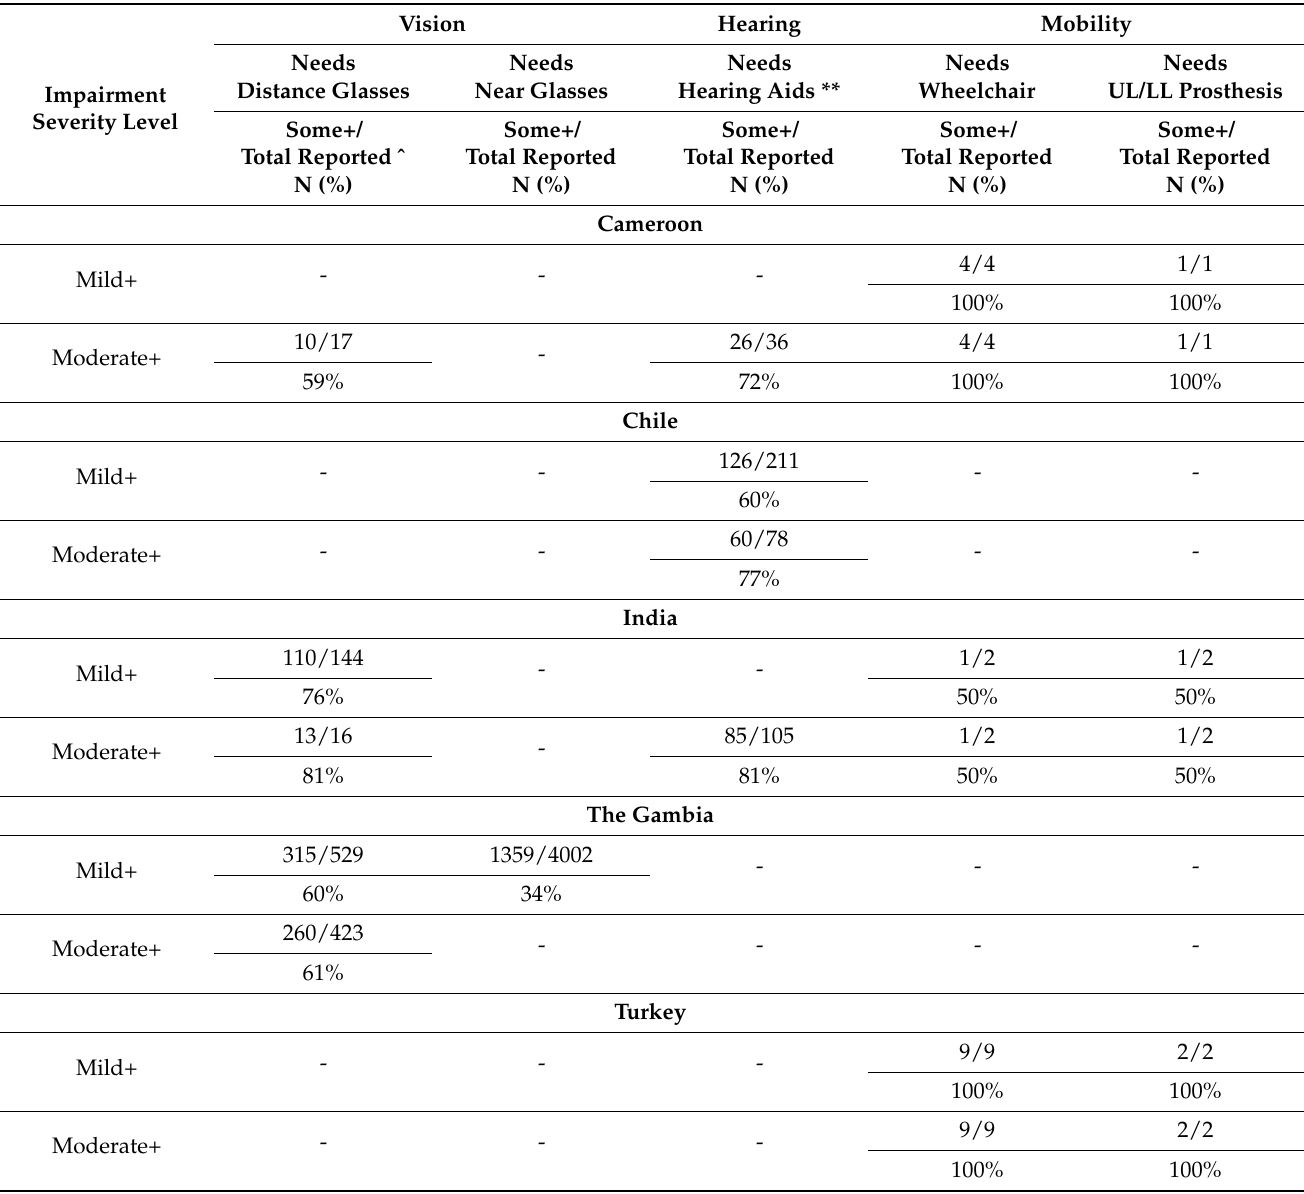
Table 4. Proportion of participants assessed as having a clinical impairment who need * glasses, hearing aids, wheelchairs and protheses that were identified by WG some+ difficulty